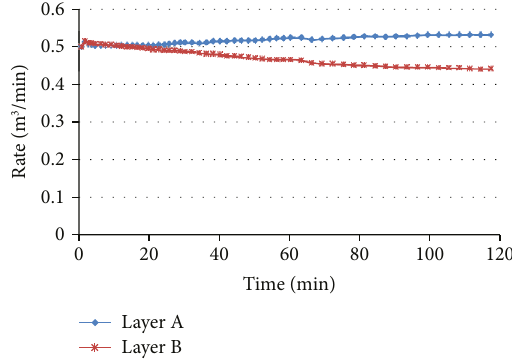
Figure 17: Rate allocation in two layers.